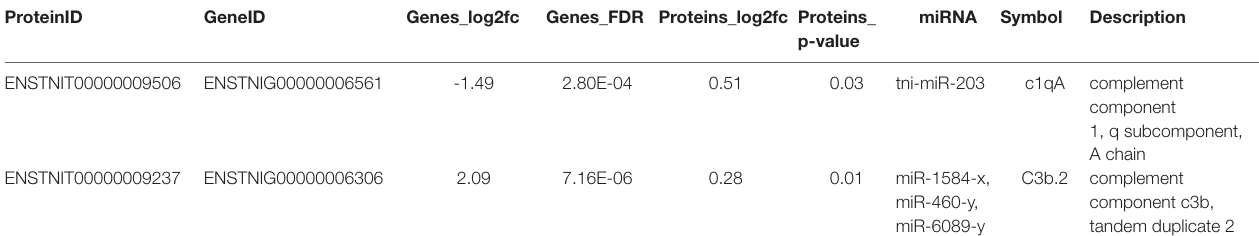
TABLE 3 | Statistical table of joint analysis of all differences in transcriptome protein miRNA.